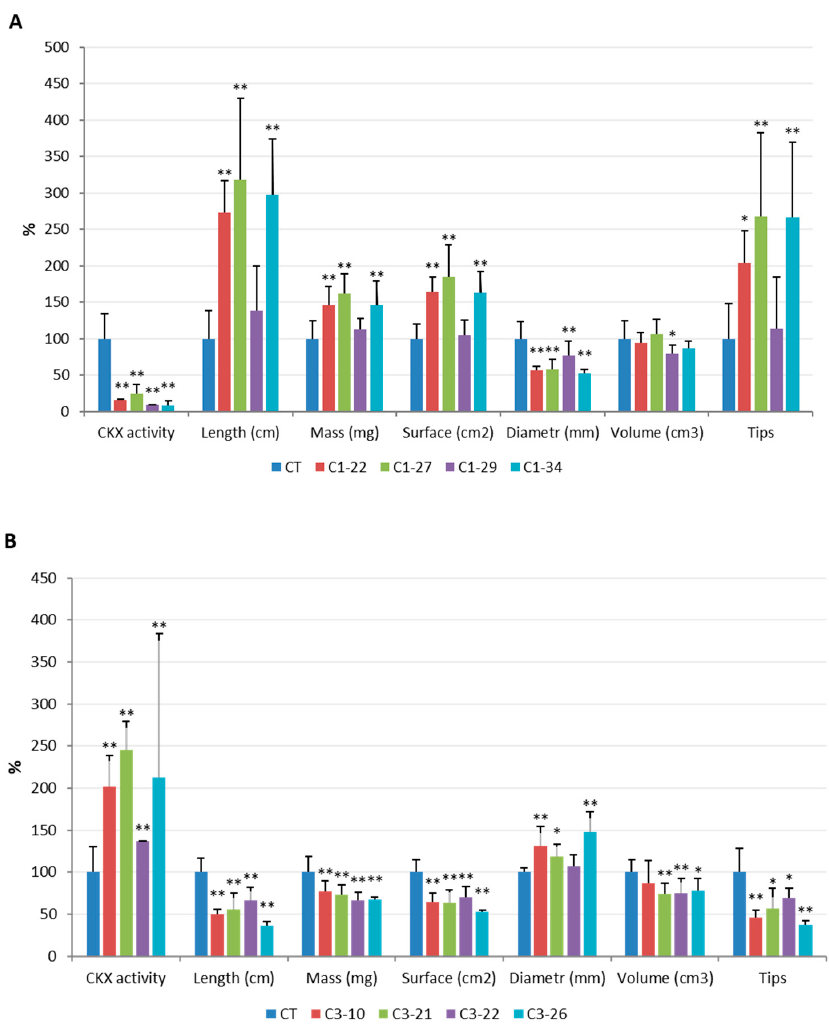
Figure 10. Comparison of enzymatic CKX activity and select morphological characteristics of 10-day-old roots from ckx1 ( A ) and ckx3 ( B ) mutant lines. The data are presented as the percentage of the values in control plants (CT), which were set to 100%, the actual values were shown in Tables S12 and S13. Root parameters were measured for seven to 10 biological replicates, which were significantly di ff erent from control at * p < 0.05, ** p < 0.01.